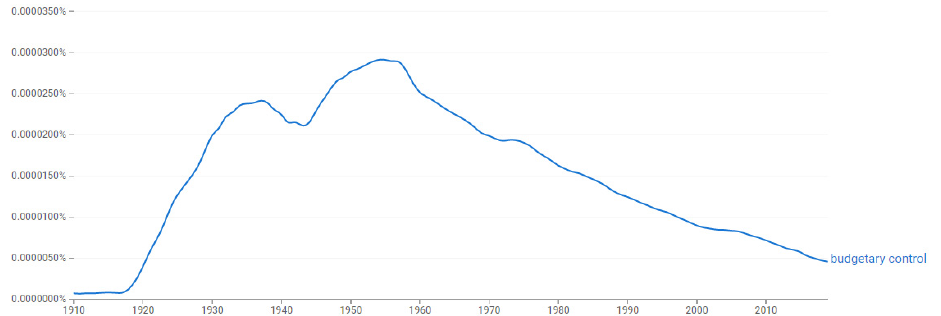
Figure 2. Evolution of the term “budgetary control” (Data source: Google Books Ngram Viewer, available at http://books.google.com/ngrams, retrieved 25 August 2022).